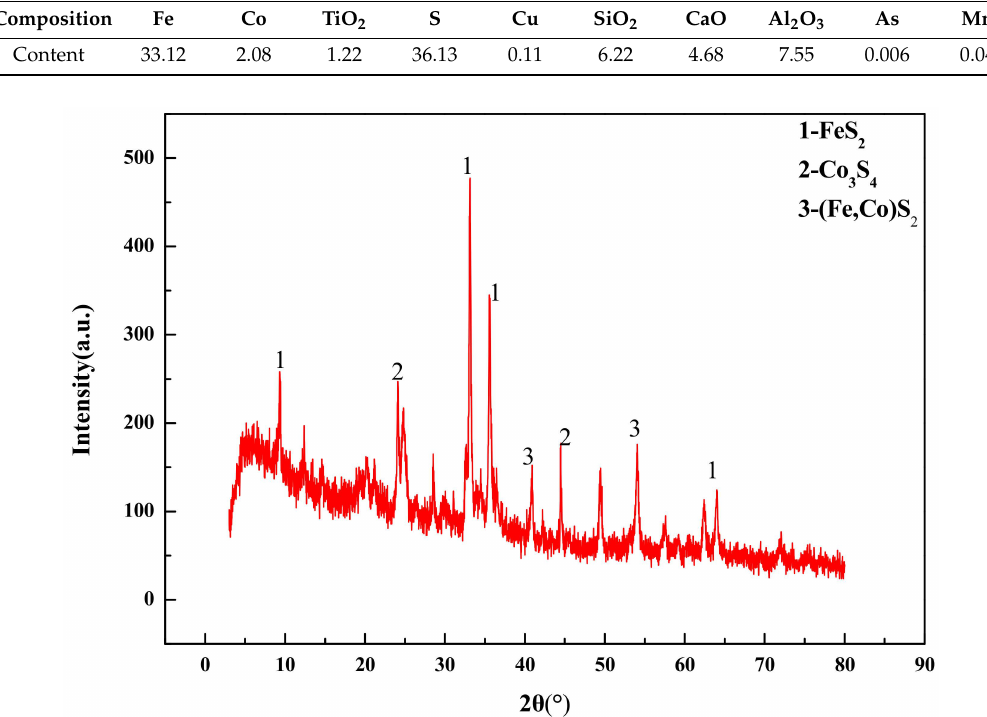
Figure 12. XRD analysis of cobalt–sulfur